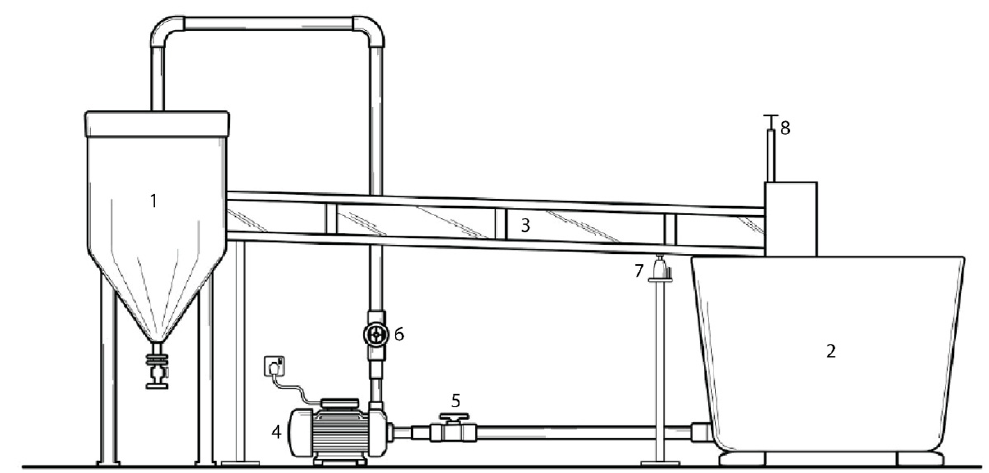
Figure 1. Experimental setup consisting of two water tanks (1 and 2), a glass channel in which the transplants were exposed, covered with a glass lid (3), water pump (4), main valve (5), water flow regulator valve (6), hydraulic jack (7) and a gate